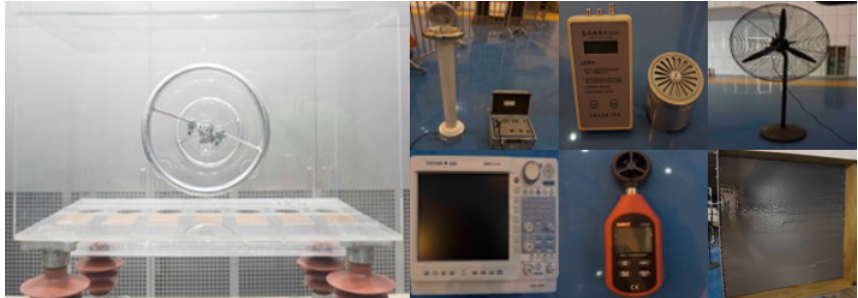
Figure 6. Experimental